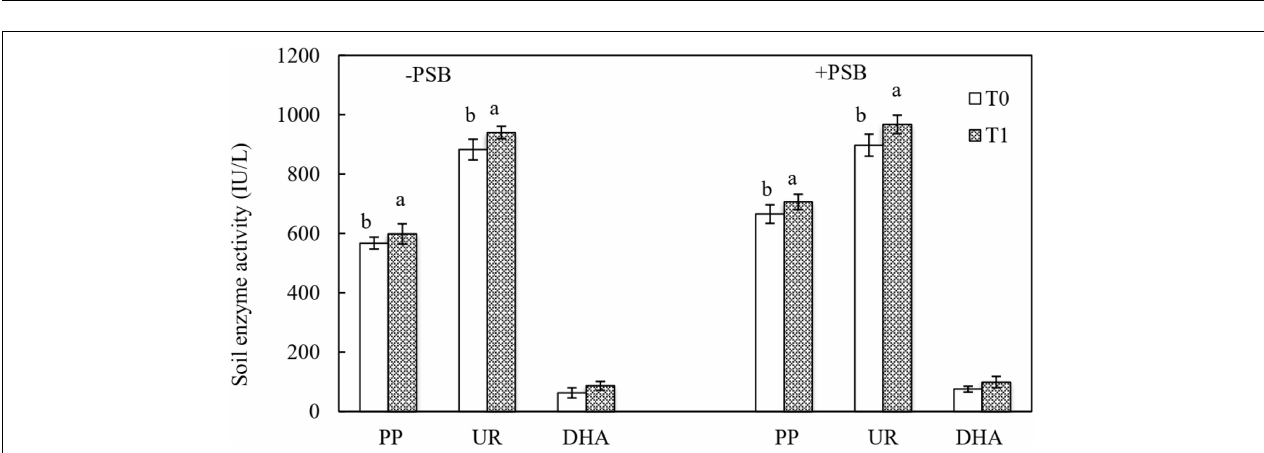
Figure 7 shows comparisons between two groups: T0 vs. T0P ( Figure 7A ) and T1 vs. T1P ( Figure 7B ). Within each comparison, significant differences in bacterial groups were determined using t -tests. Compared